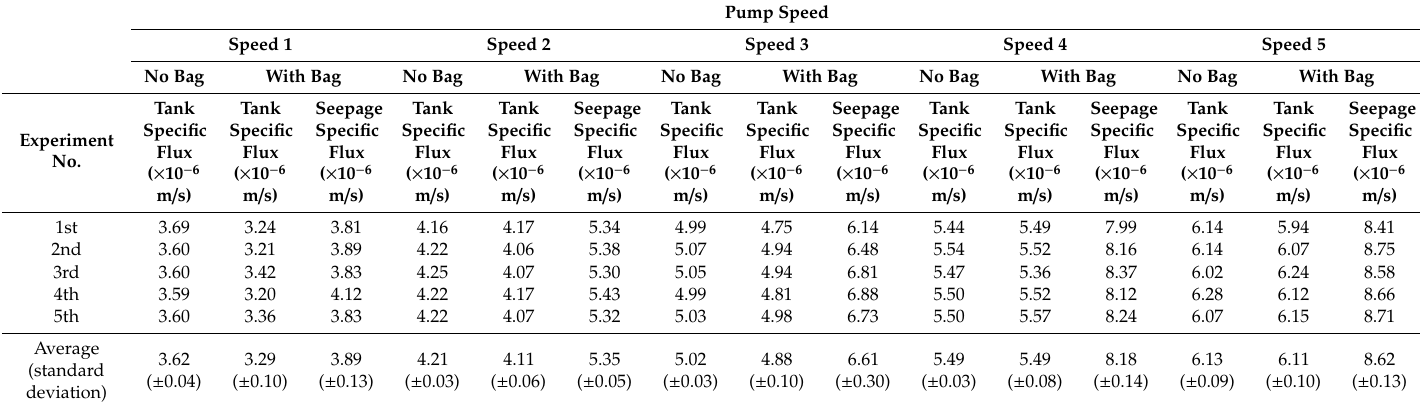
Table 4. Outflux measurement experiment using the Type 1 collection bag.